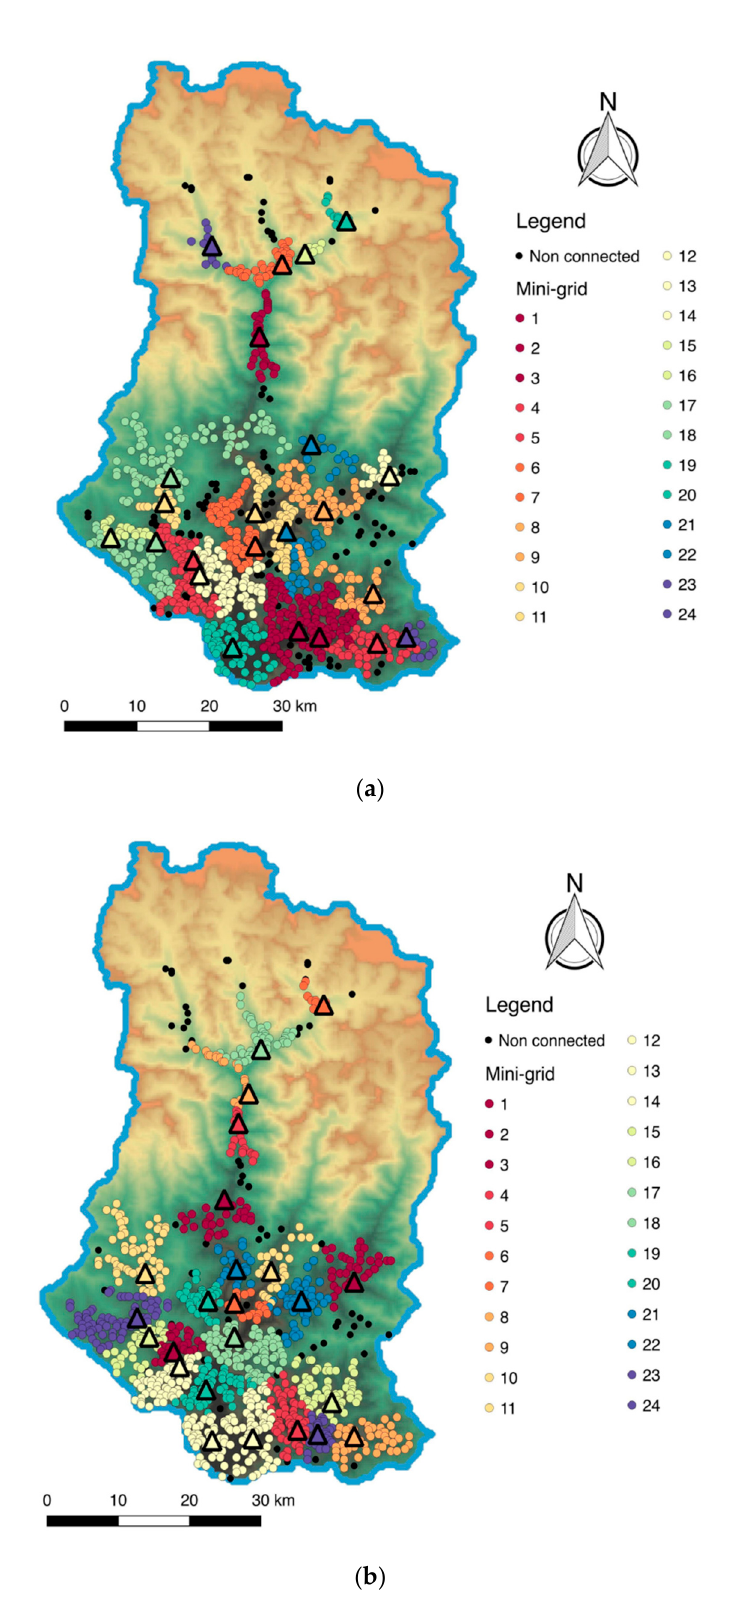
Figure 10. Visual layout of the designed mini-grids using the original clustering method by Ranaboldo et al. [80], and Poli-ROR . Each color represents a mini-grid with the corresponding demand points (villages), and the designed hydro-power plants (triangles). A fixed number of clusters n r = 24 as from the method by Ranaboldo et al. [80] is used for reference. ( a ) Ranaboldo et al. [80]. ( b ) Poli-ROR .